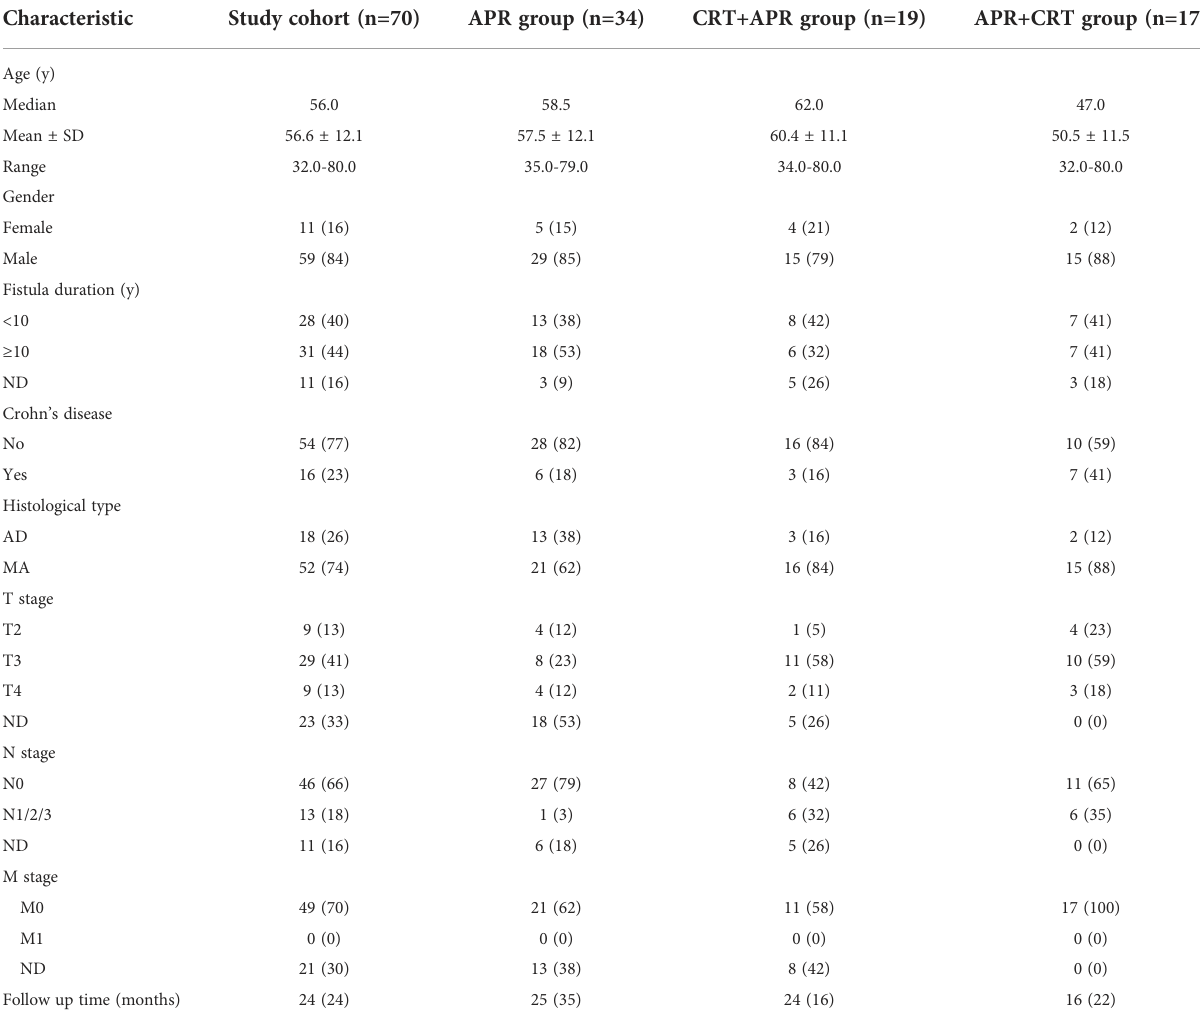
TABLE 2 Systematic review: Patient characteristics (n=70).